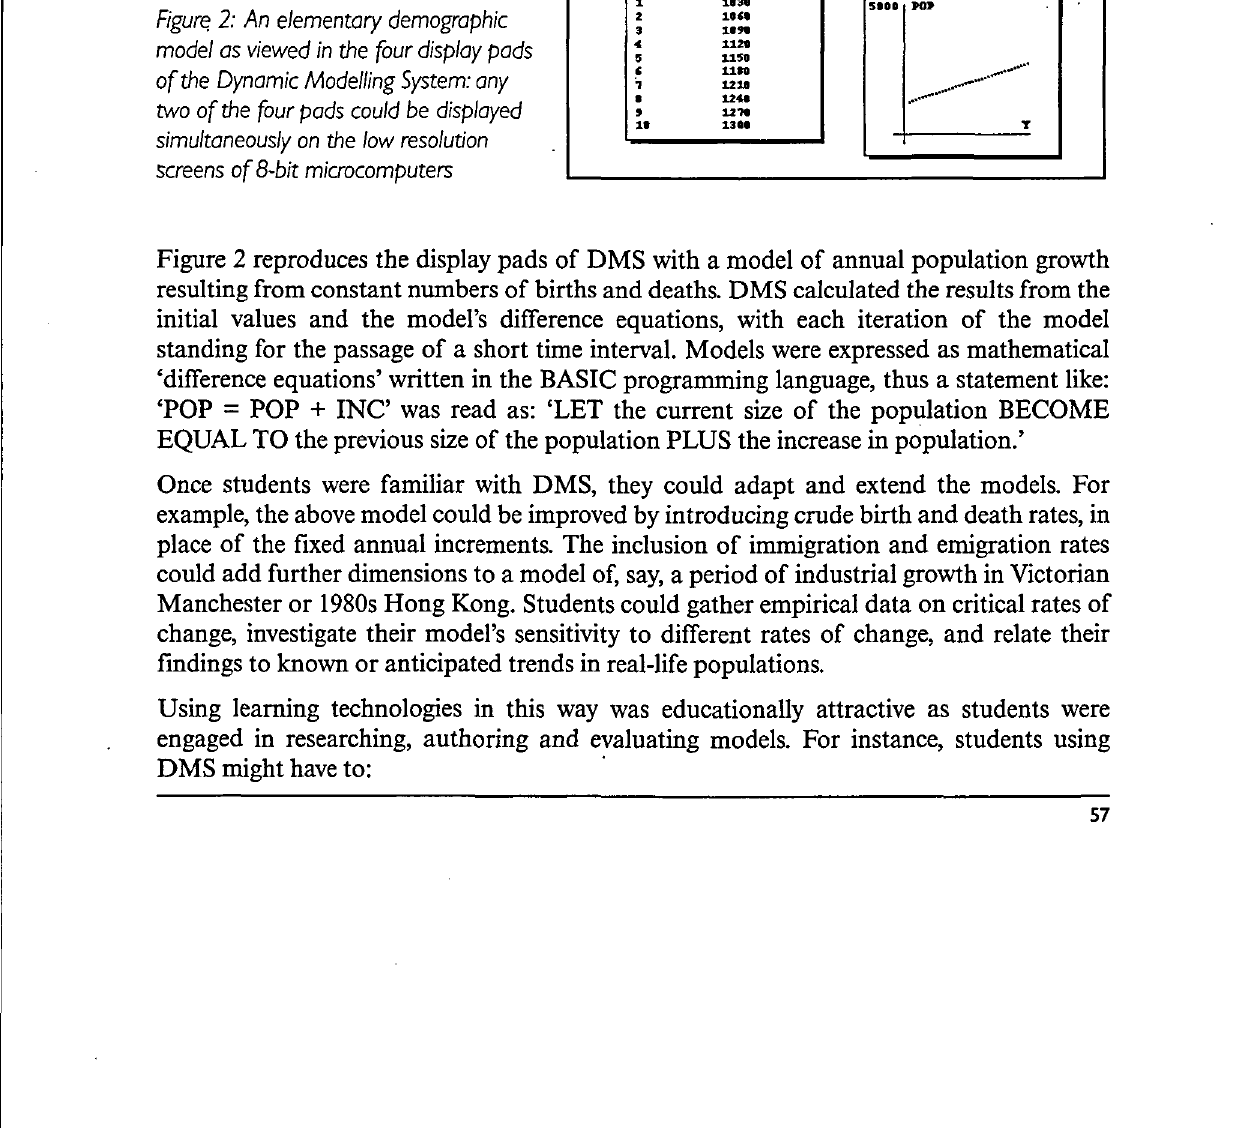
Figure 2: An elementary demographic model as viewed in the four display pads of the Dynamic Modelling System: any two of the four pads could be